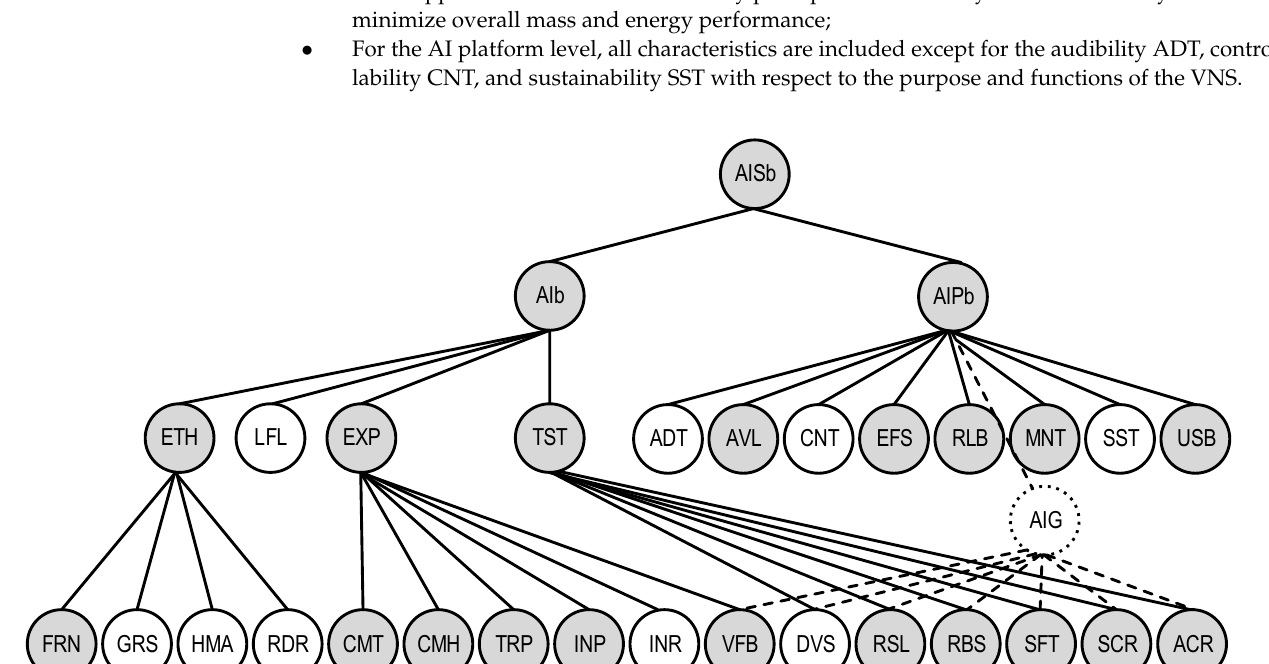
Figure 10. The graph representation of the quality model of VNS as an AI system with built-in CNN.